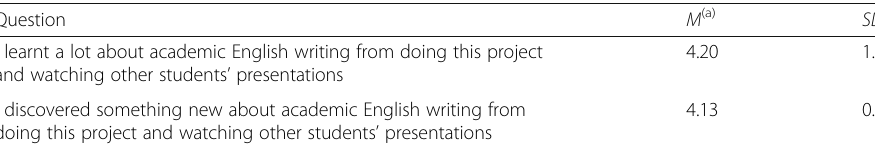
Table 4 Follow-up questionnaire learning items (n = 16) Question M (a) SD